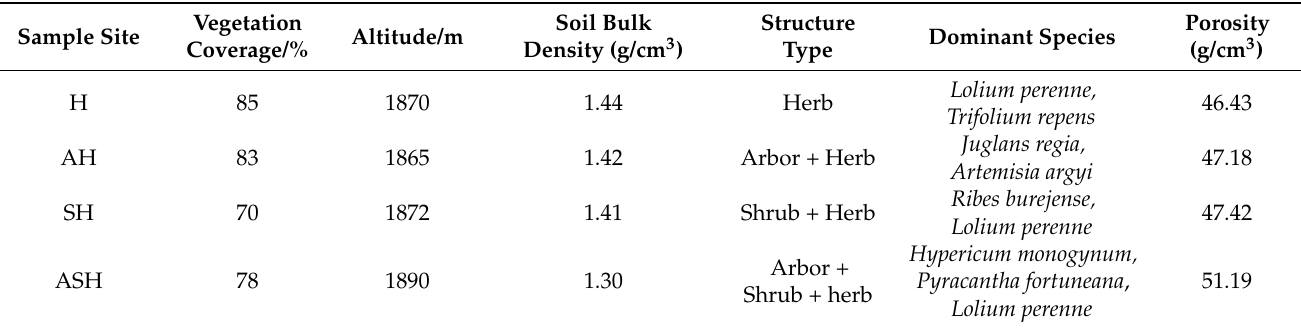
Table 1. Basic information of the sample